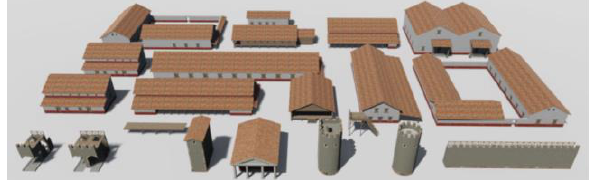
Figure 8: Castellum main component library